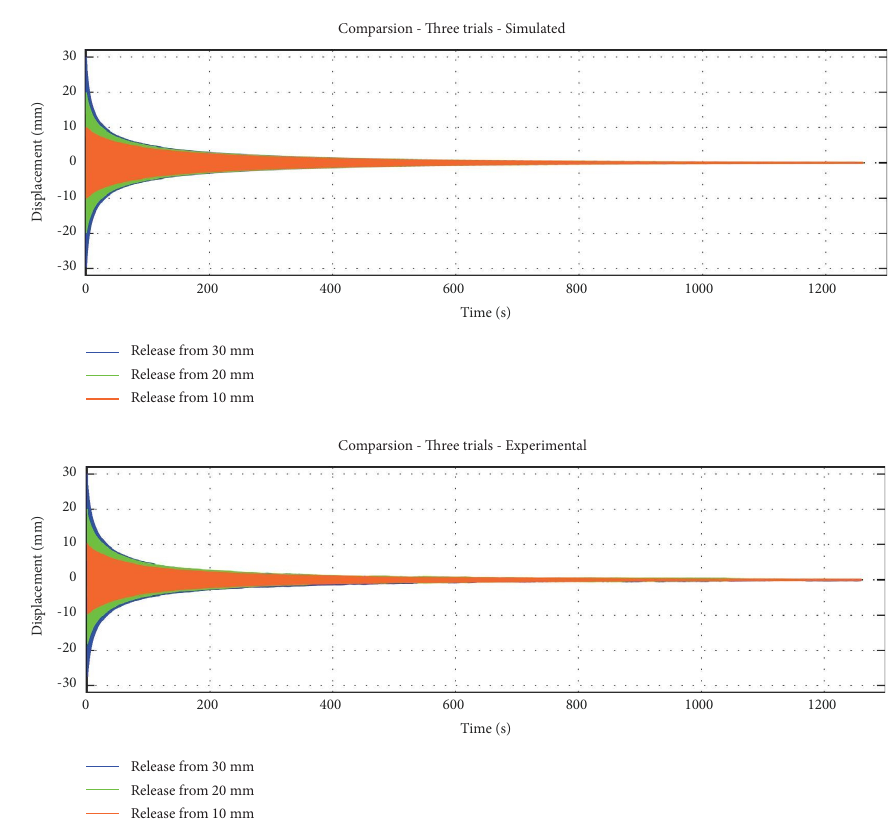
Figure 9: Simulated and real time responses of free vibrations for diferent initial conditions. First model without damper.